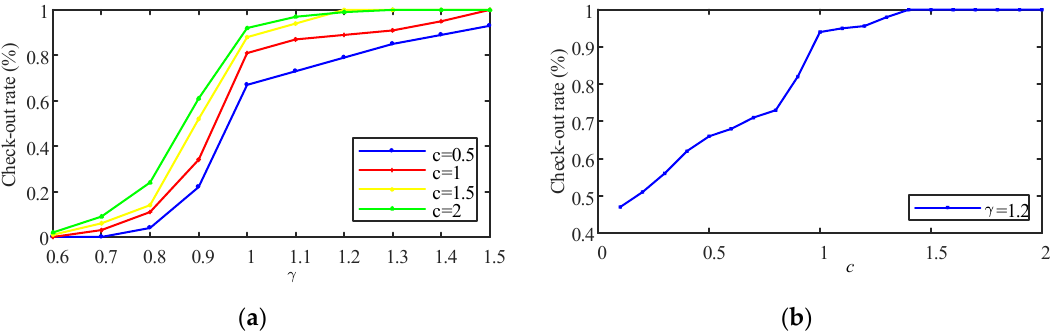
Figure 9. Parameter setting of JIT. ( a ) Check-out rates (CO%) at different values γ . ( b ) Check-out rates (CO%) at different values c .